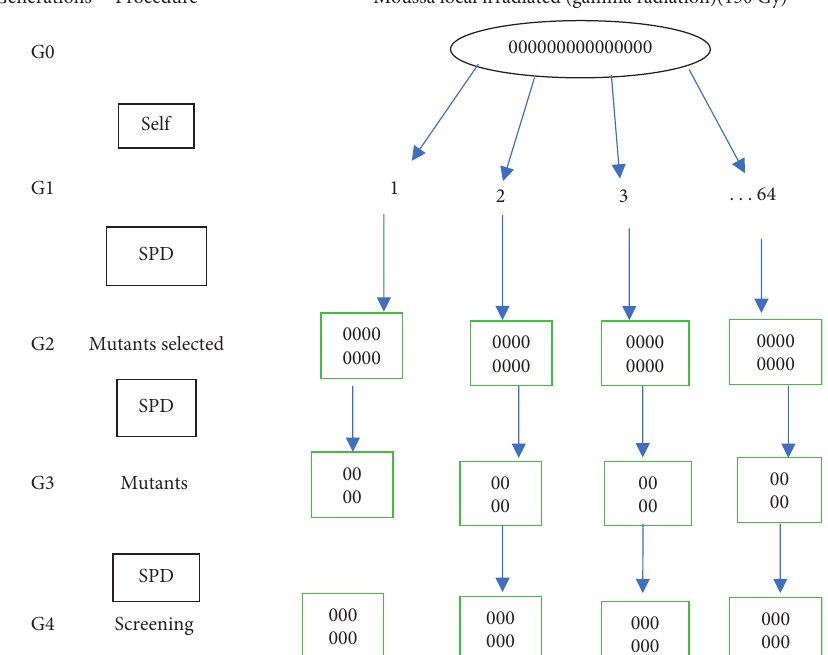
Figure 1: Schematic representation of the development of mutant lines. SPD: single plant descent; circles: individual plants; rectangles: